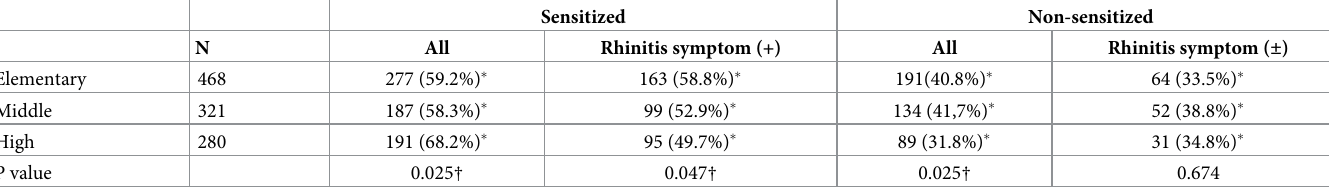
Table 2. Prevalence of rhinitis symptoms in sensitized and non-sensitized children according to age